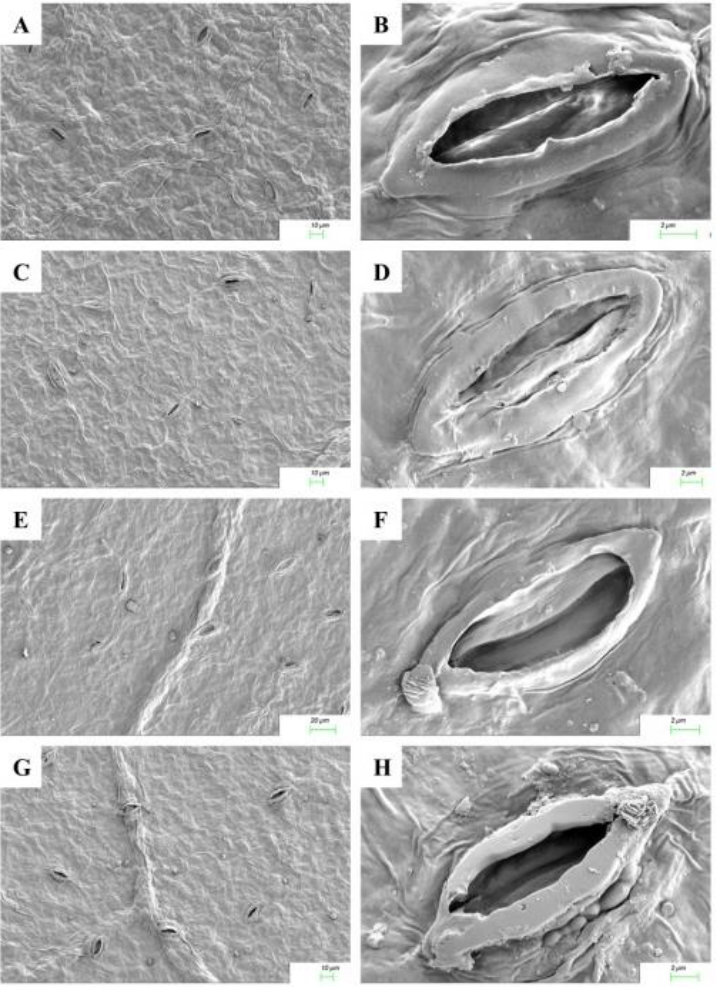
Figure 4. Scanning electron micrographs of adaxial leaf surfaces and stomata of the cotyledonary leaves of R. communis after 6 day of exposure to CuSO 4 (160 µM) and cytokinin (KIN and BAP) treatments in Hoagland’s nutrient medium. ( A )&( B ): Control; ( C )&( D ): 160 µM CuSO 4 ; ( E )&( F ): 160 µM CuSO 4 + KIN; ( G )&( H ): 160 µM CuSO 4 + BAP.